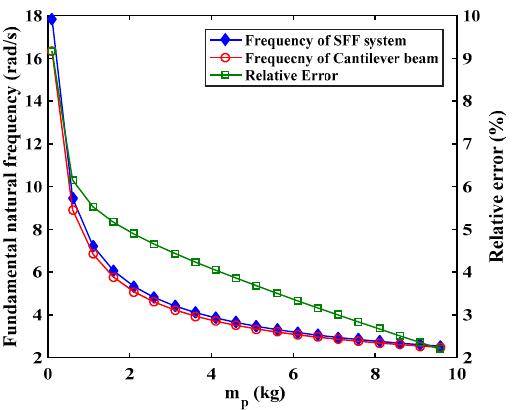
Figure 5. Fundamental natural frequencies of the SFF system and the cantilever